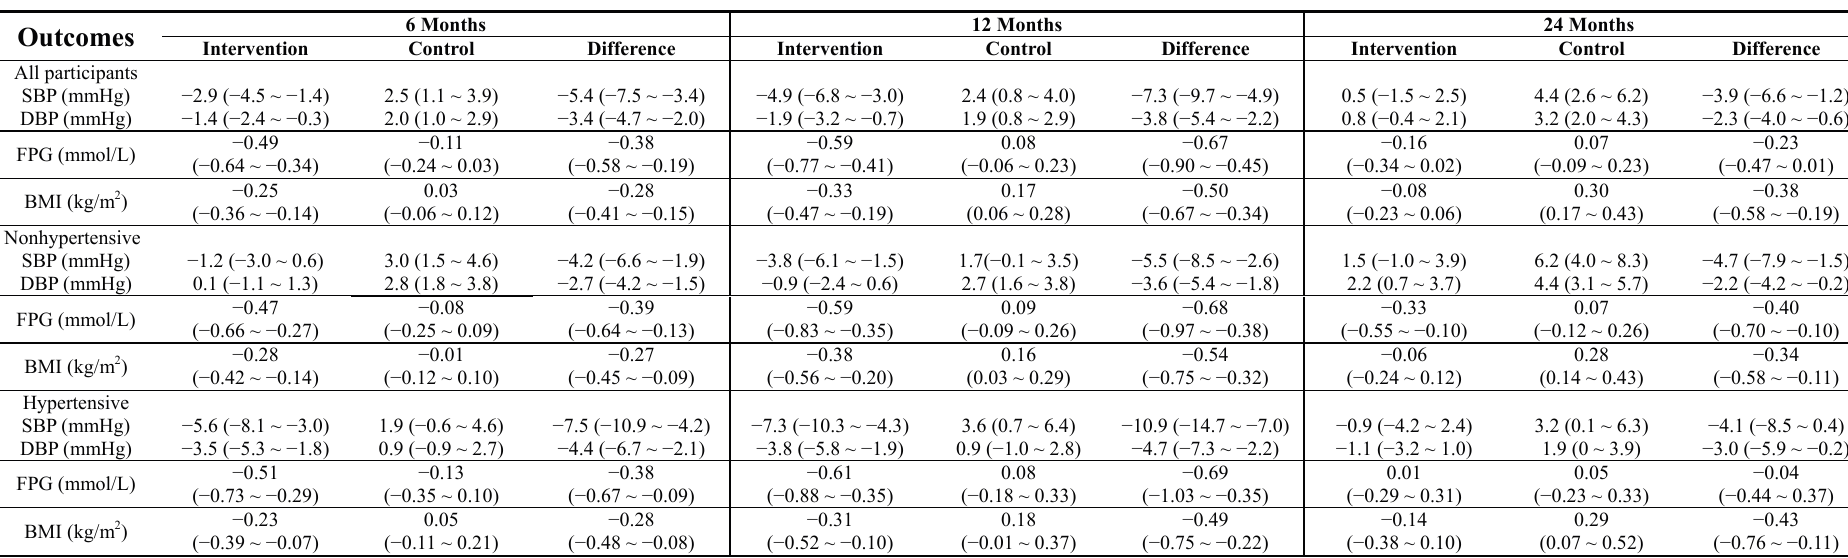
Table 4. Mean changes (95%CI) in blood pressure, glucose and BMI at follow-up by baseline pressure and intervention status * .